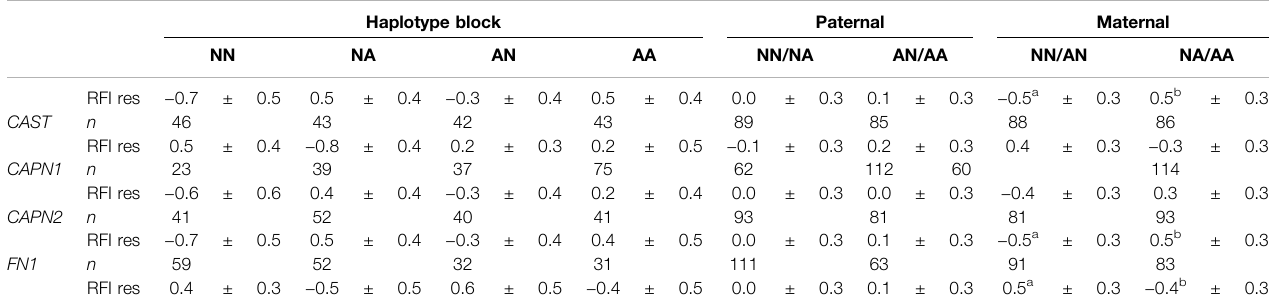
TABLE 8 | RFI residuals based on haplotype block analysis. Haplotype block Paternal